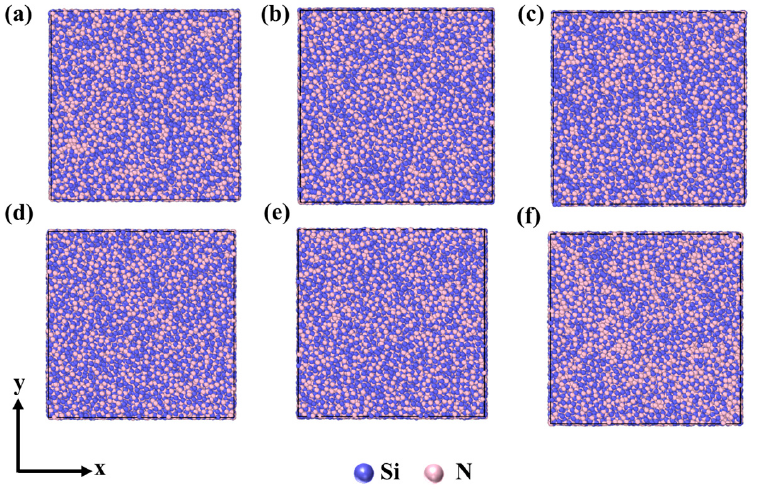
Figure 7. The models of SiN x . ( a ) x = 4/3, ( b ) x =5/4, ( c ) x = 6/5, ( d ) x = 7/6, ( e ) x = 8/7, ( f ) x = 1/1. Table 1. The simulation parameters in SiN x heating process.